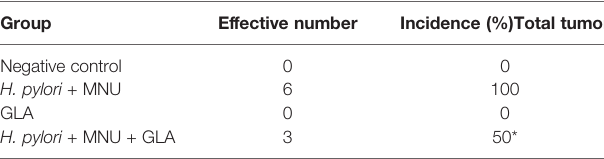
TABLE 1 | Incidence of gastric tumors in the in vivo